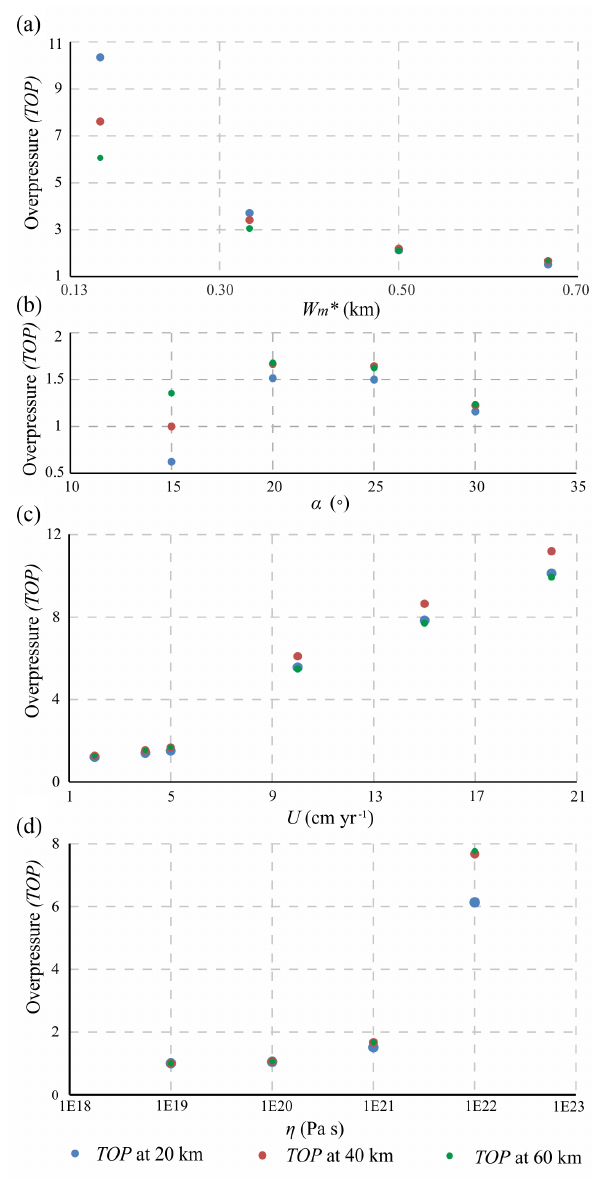
Figure 3. Graphs showing the dependence of overpressure fac- tor (TOP) on normalized width of channel mouth W ∗ m (a) , chan- nel dip α (b) , underthrusting velocity U (c) , and viscosity in the channel η (d) . For each tested variable, other values are kept con- stant: W ∗ m = 100 / 150 = 0 . 67 (except in a ), α = 20 ◦ (except in b ), U = 5cmyr − 1 (except in c ), η = 10 21 Pas (except in d